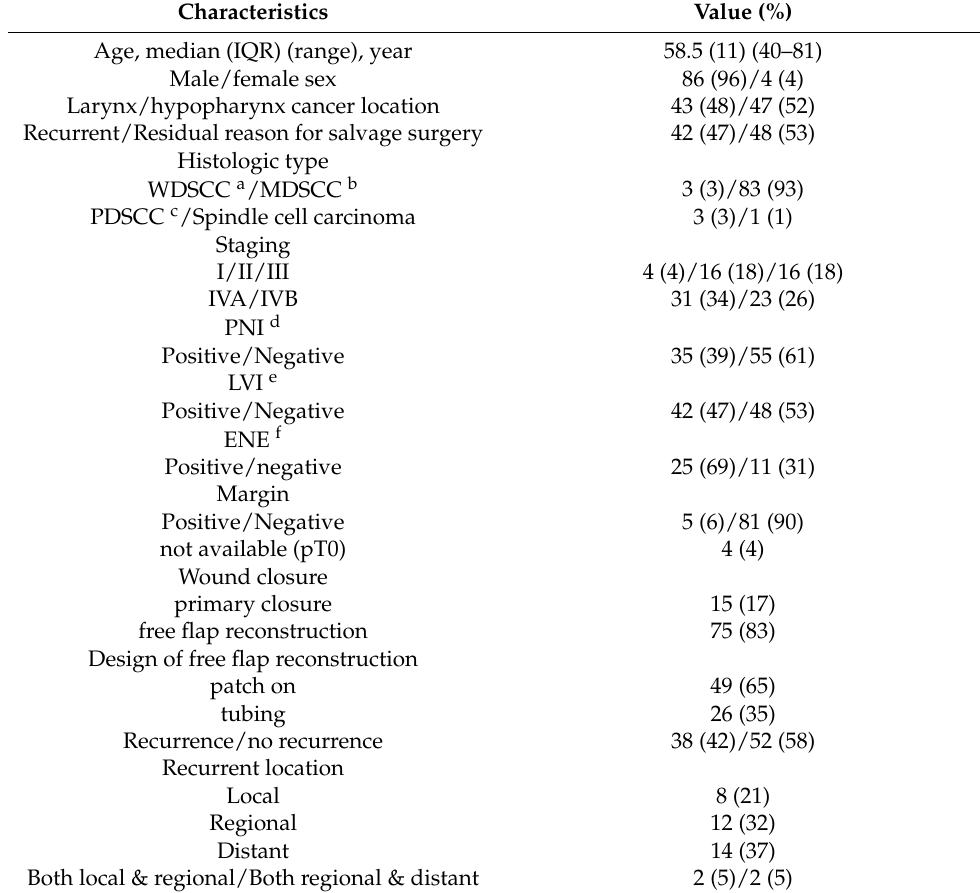
Table 1. Clinicopathological characteristics of 90 patients who underwent salvage total